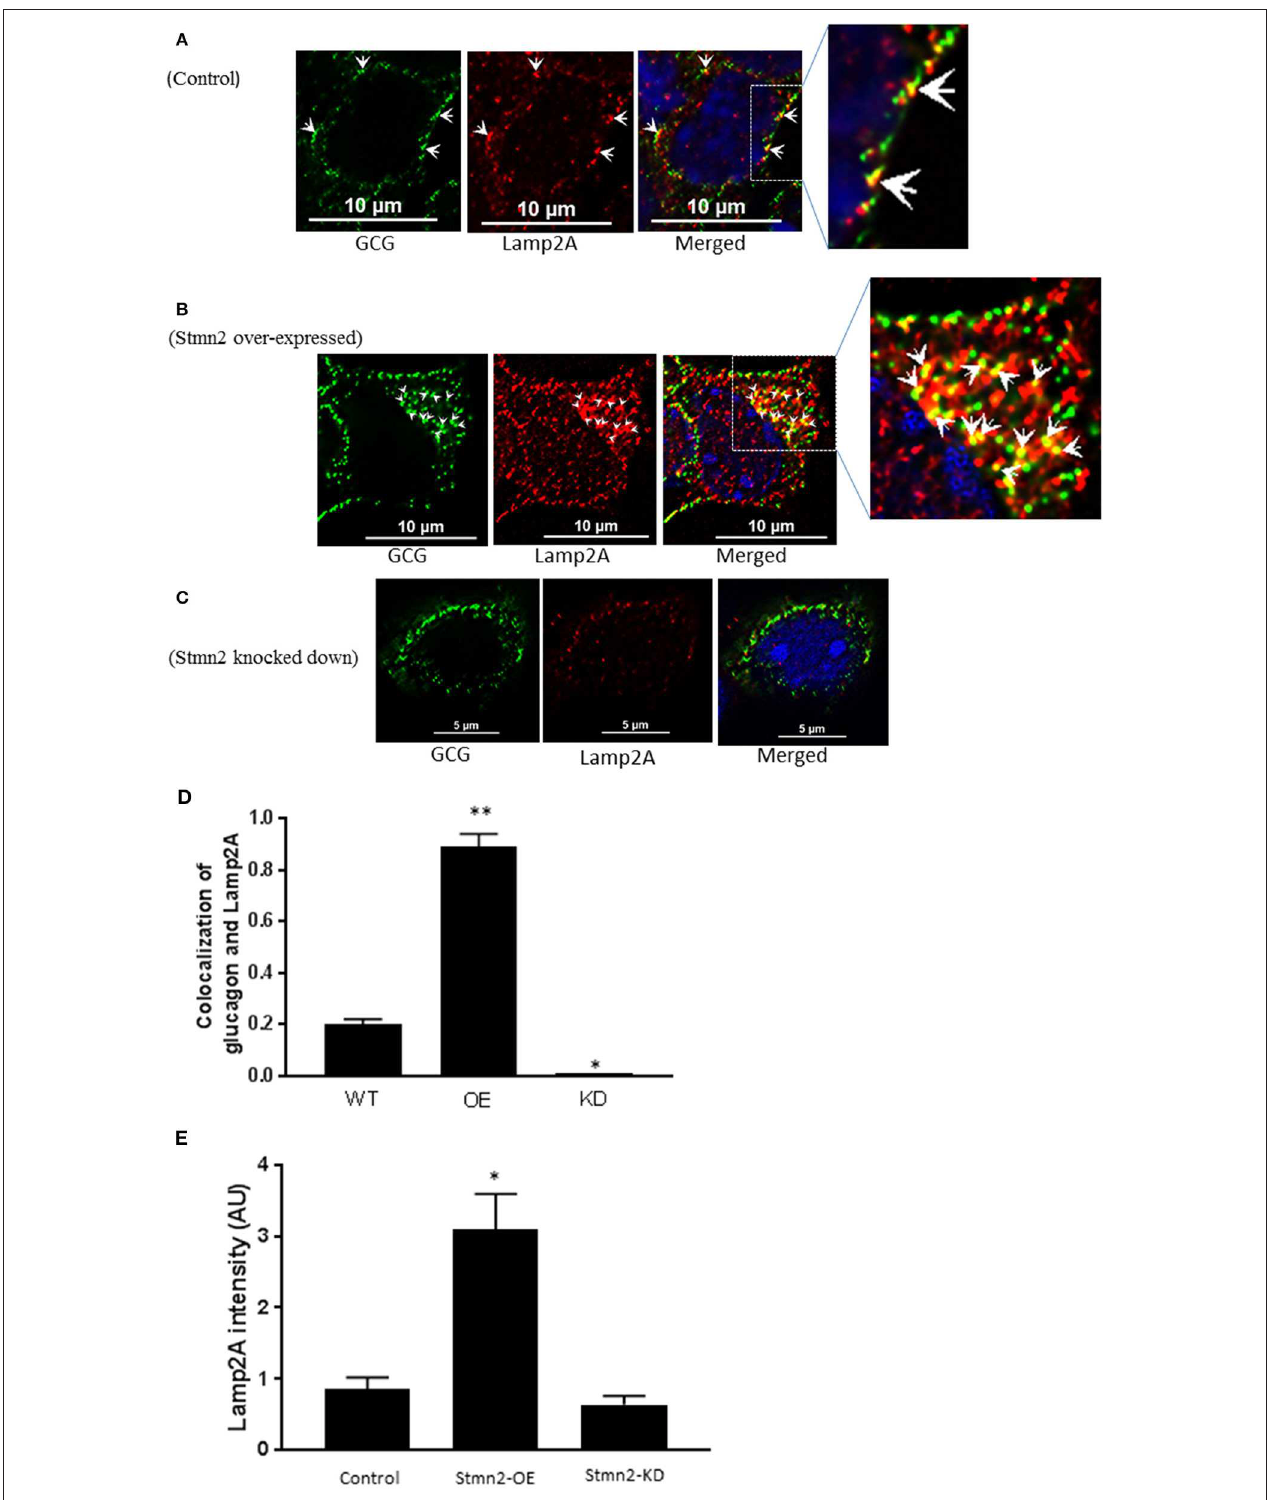
FIGURE 6 | Overexpression of Stathmin-2 increases the presence of glucagon in late endosomes/lysosomes. After transfection with either empty vector (A) , vector encoding Stmn2 (B) or siRNAs against Stmn2 (C) , α TC1-6 cells were immunostained using primary antibodies against glucagon and the late endosome-lysosome